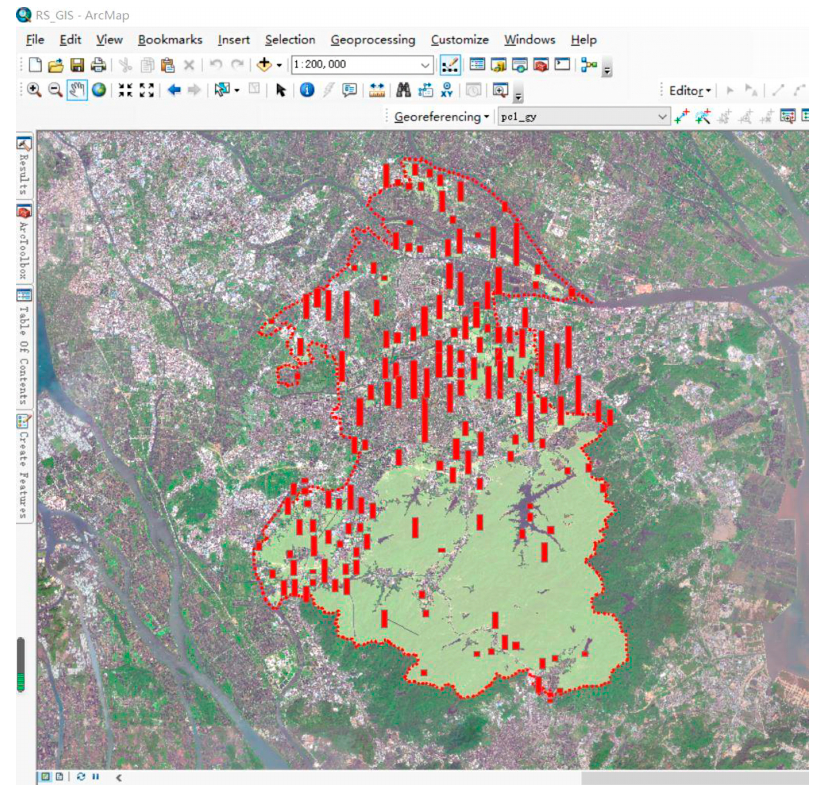
Figure 16. The landscape activity map. Table 15. Landscape activity eigenvalue table (partial